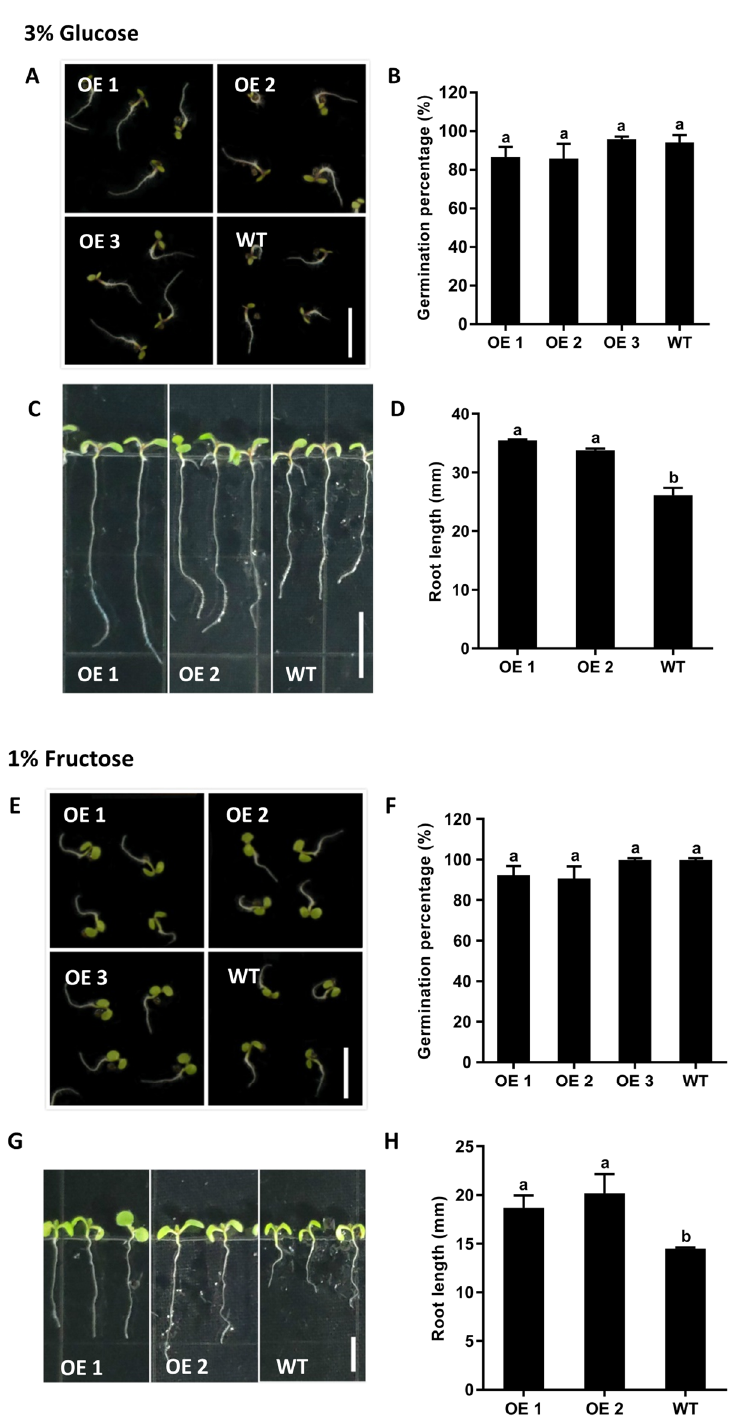
Figure 5. Overexpression of CmTST1 in Arabidopsis seedlings (OE) improved the root growth under (3% w / v ) Glc and (1% w / v ) Fru conditions. ( A , E ) The phenotype of 3-day-old seedlings. ( B , F ) Germination percentage of OE and WT Arabidopsis seeds. ( C , G ) Seedlings of OE and WT after growing on 3% Glc (C) or 1% Fru (G) 6S for 9 days. ( D , H ) Average root length of seedlings after growing on 6S 3% Glc ( D ) or 1% Fru ( H ) for 9 days. WT, wild type. Bar = 5 mm. Results represent at least three biological replications. Lowercased letters above the bar indicate that significant di ff erences between the OE seedlings and the WT were assessed by one-sided paired t -tests ( p < 0.05). 2.4. Ectopic Overexpression of CmTST1 in Arabidopsis Affects the Expression of SUC and STP Genes